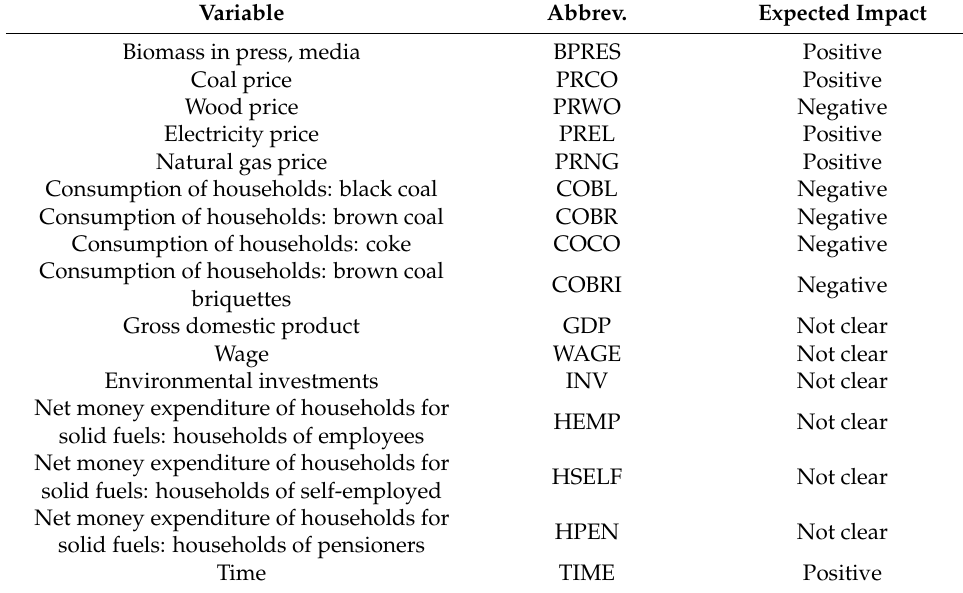
Table 2. Expected impact of variables.